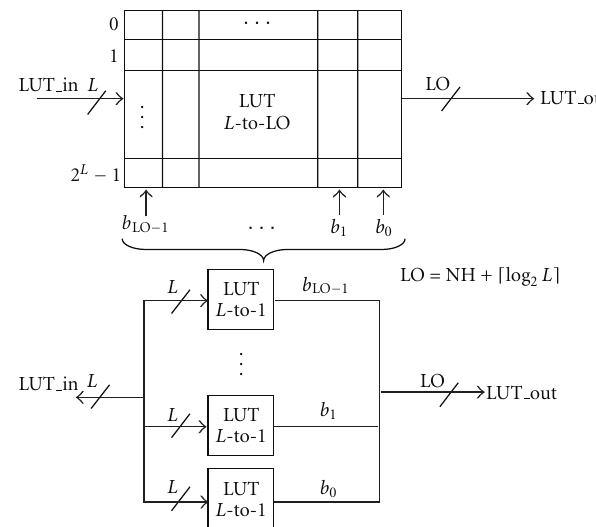
Figure 4: Realization of an L -to-LO LUT using LO L -to-1 LUTs.